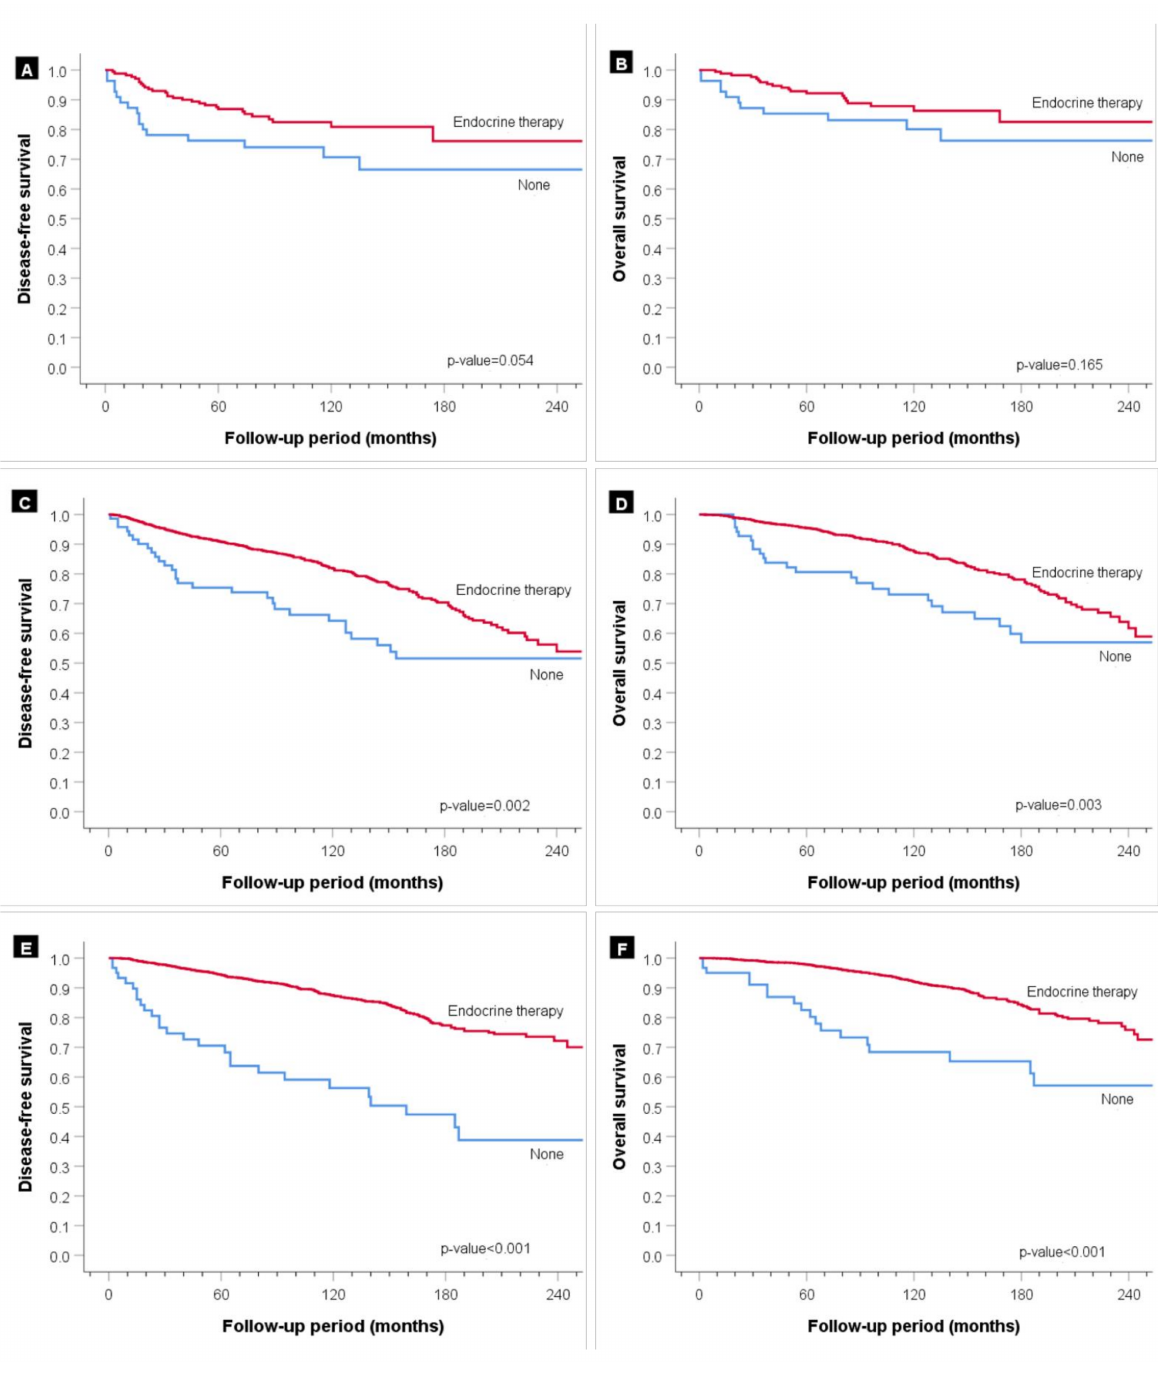
Figure 7. Survival analysis of the patients in the three groups with hormone receptor-positive status according to endocrine therapy. ( A ) Disease-free survival (DFS) and ( B ) overall survival (OS) for the low group, ( C ) DFS and ( D ) OS for the single high group, and ( E ) DFS and ( F ) OS for the both high